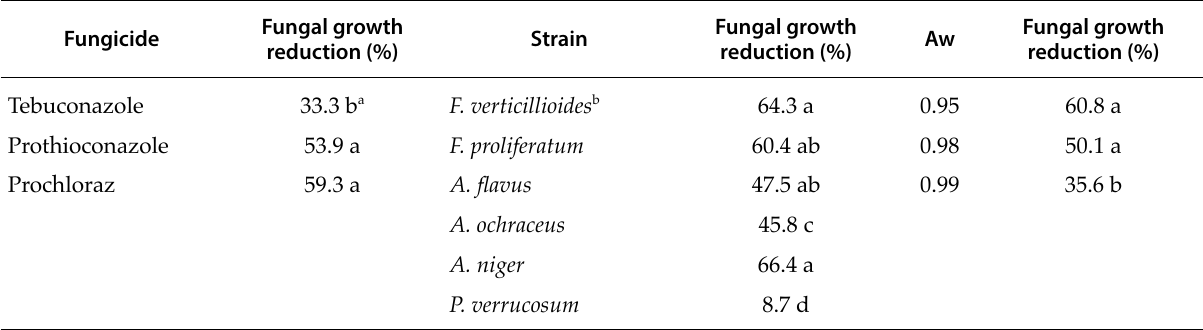
Table 5. Analysis of variance results for six fungal strains tested on MA agar amended with three fungicides and incubated at 25°C for 9 d at three different levels of a w from 0.95 to